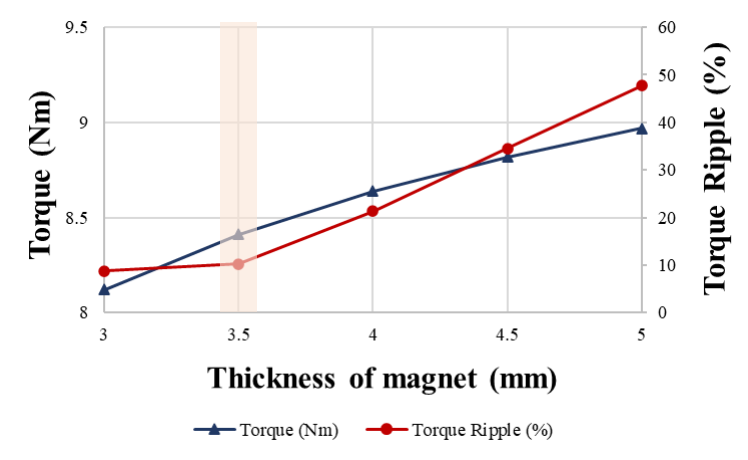
Figure 15. Rotor variable for the thickness of the magnet.